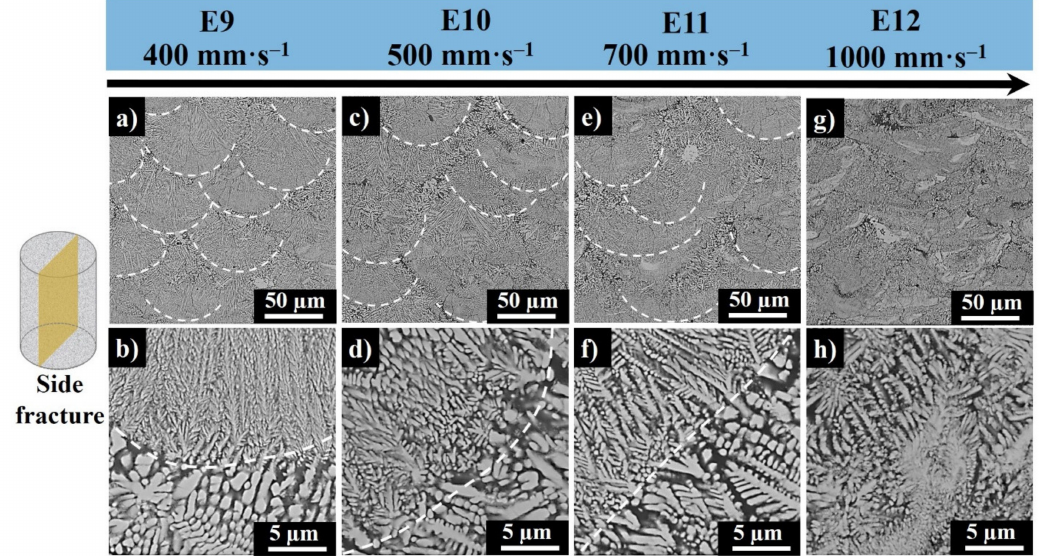
Figure 10. Side surface SEM images E9 ( a , b ), E10 ( c , d ), E11 ( e , f ), and E12 ( g , h ) produced at 200W laser powers and at 400 mm · s − 1 , 500 mm · s − 1 , 700 mm · s − 1 , and 1000 mm · s − 1 scanning speed, respectively (the white dashed semi-ovals in panels ( a – g ) represent melt pools, and the white dashes in panels ( b – f ) show the morphology transition zone from melt pool core to